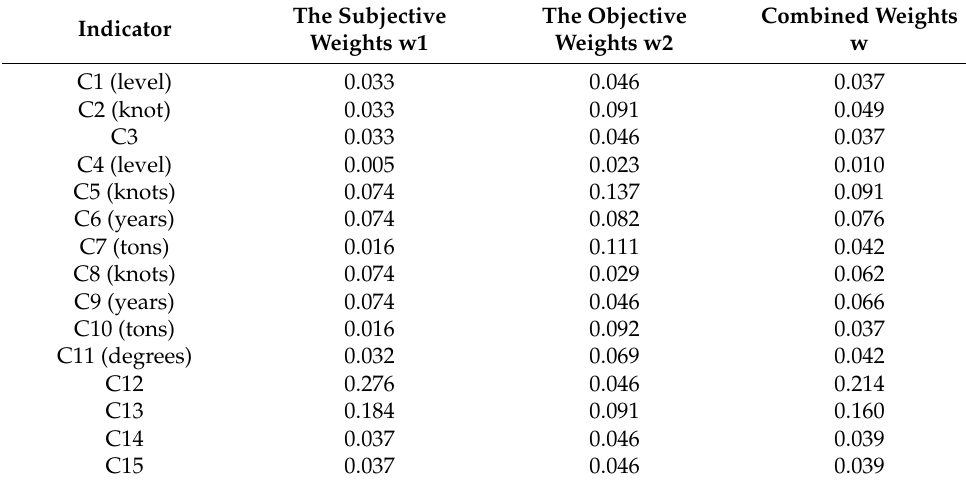
Table 7. The final combination weights.